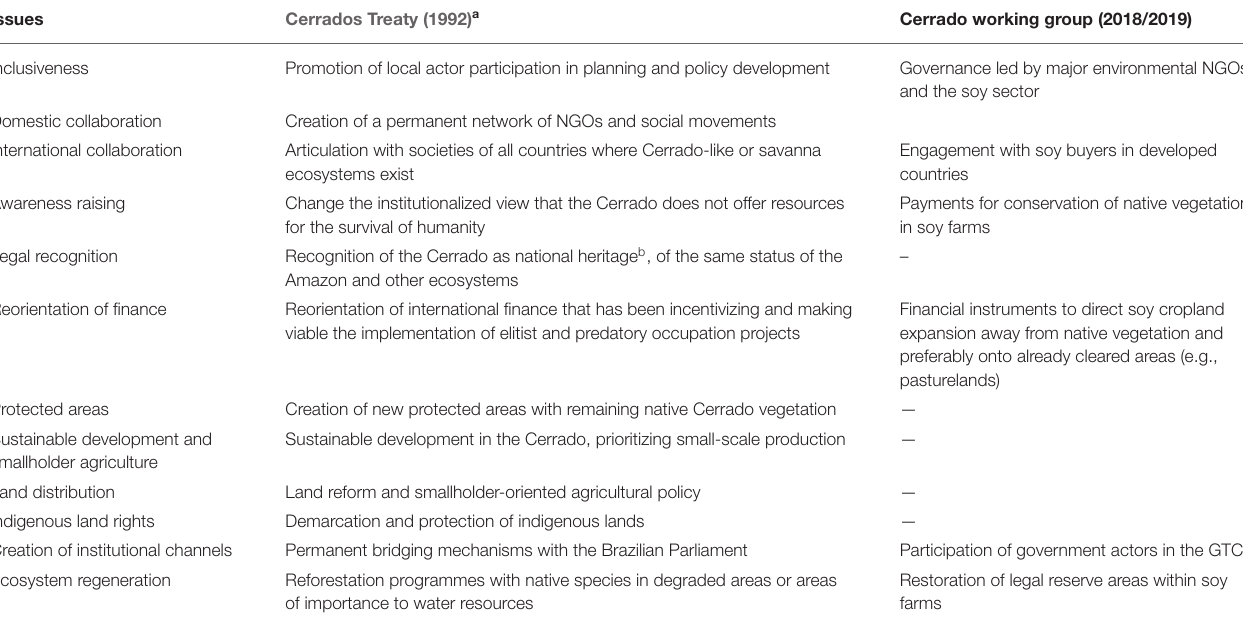
TABLE 2 | Sustainability agendas for the Cerrado over